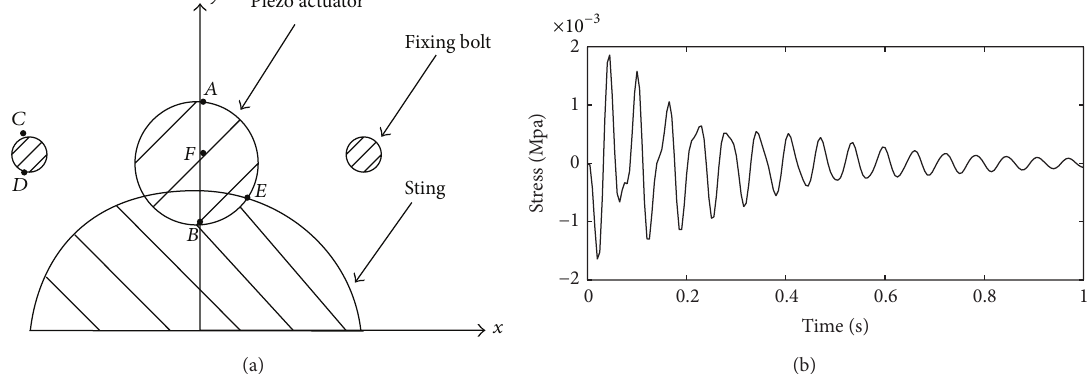
Figure 8: (a) shows diagram of cross-section at sting end and (b) shows the transient response at point A of the section.